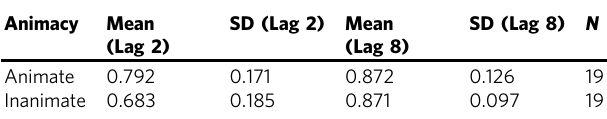
Table 2 Mean and SDs for T2 performance for animacy Animacy Mean (Lag 2) Animate